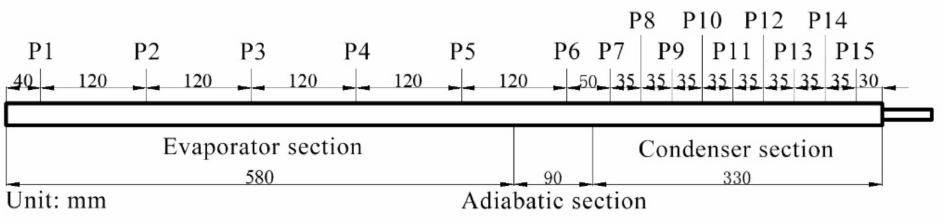
Figure 3. Location of temperature measuring points.